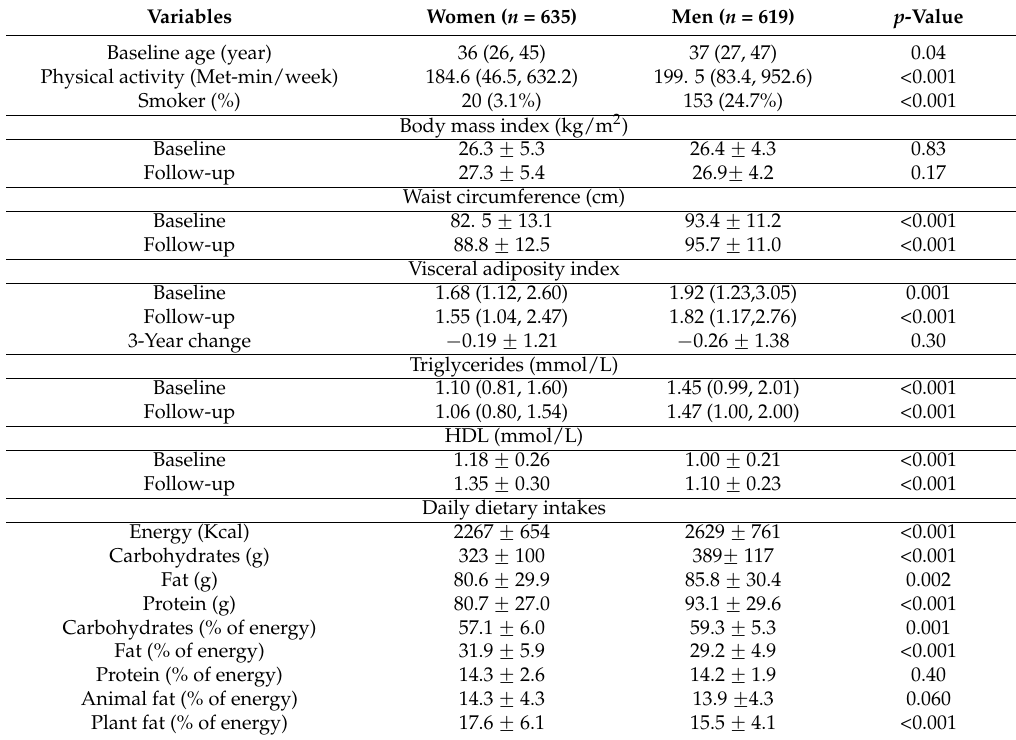
Table 1. Characteristics and dietary intakes of the